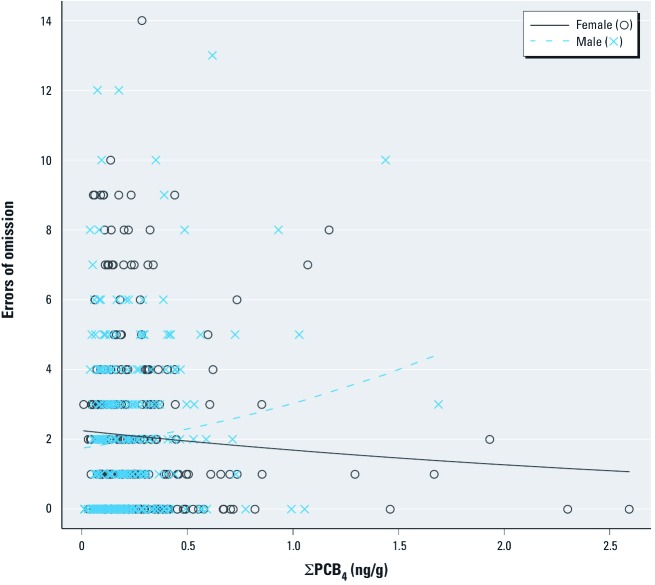
Unadjusted scatterplots and adjusted negative binomial regression lines of the association between cord serum levels of ΣPCB4 and errors of omission on the CPT by sex for 8-year-old children born in New Bedford, 1993–1998, adjusted for child’s age at examination, sex, and birth year; maternal age at birth and prenatal smoking; and maternal and paternal education. Adjusted rate ratios: females, 0.95 (95% CI: 0.86, 1.05); males, 1.11 (95% CI: 0.98, 1.27).